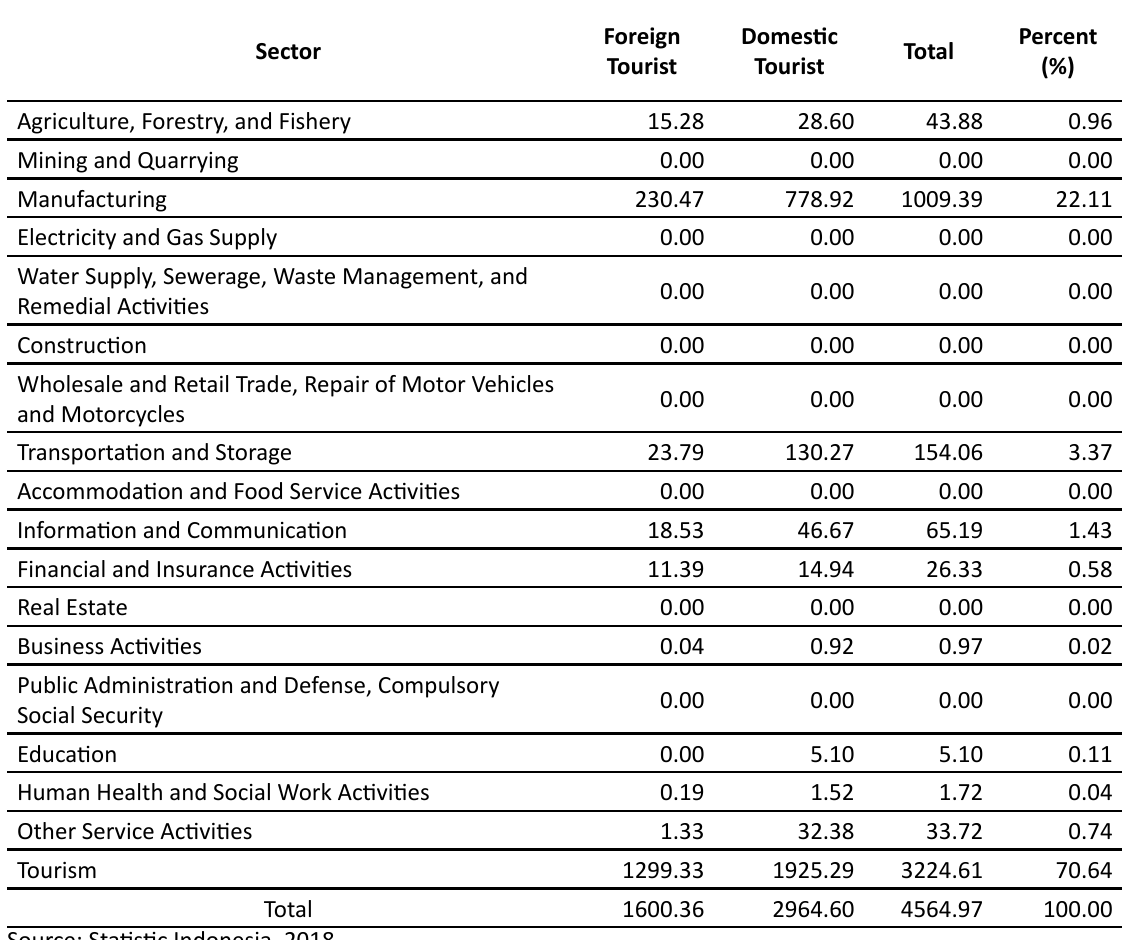
Table 6: Expenditure Structure of Foreign Tourists and Domestic Tourists Visiting North Sulawesi Province in